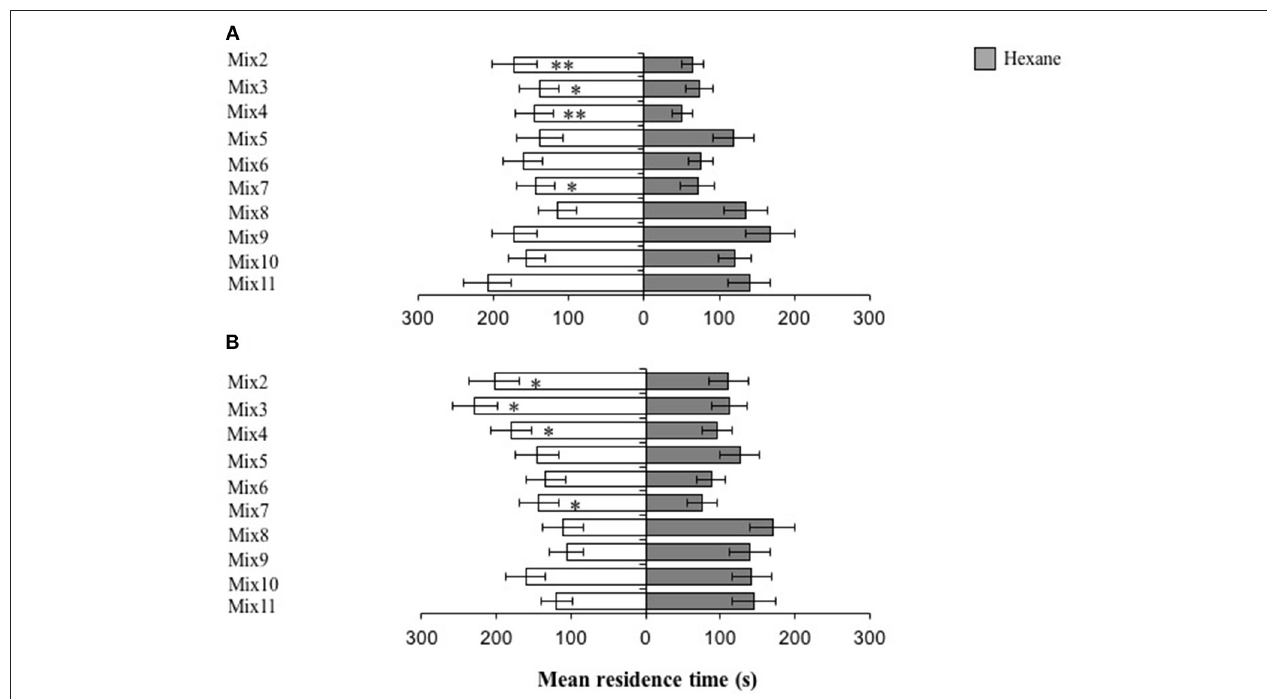
FIGURE 7 | Mean residence time in seconds of male (A) and female (B) boll weevils, Anthonomus grandis , in a Y-tube olfactometer to synthetic blends at the same concentration and rate as in volatile samples collected from boll weevil-damaged cotton plants at the reproductive stage (for composition of blends, see Table 1 ). Asterisks indicate differences (*0.05 > P > 0.01, **0.01 > P > 0.001) between pairs of treatments. Bars indicate standard error.